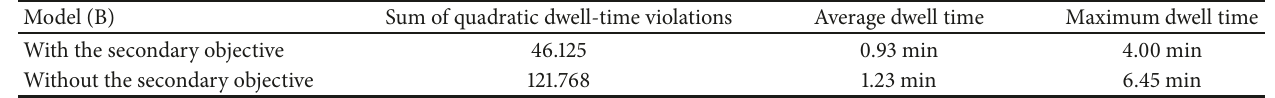
Table 4: The results of the dwell time.